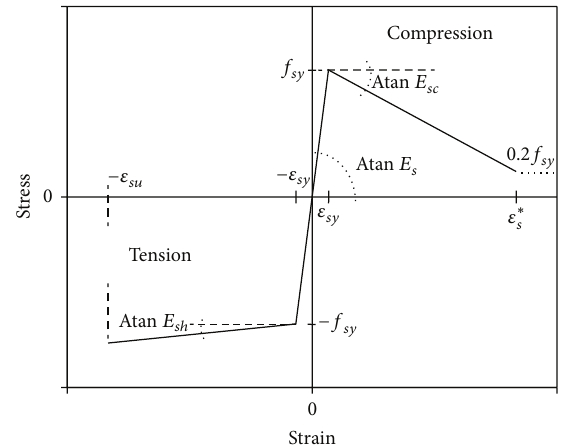
Figure 3: Constitutive law of longitudinal steel